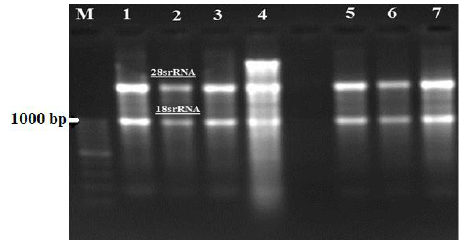
Fig. 1. RNA controlled extraction from seven samples in the 1.5% Agarose gel electrophorese: M= Gene Ruler™ 100bp DNA Ladder (Fermentas,